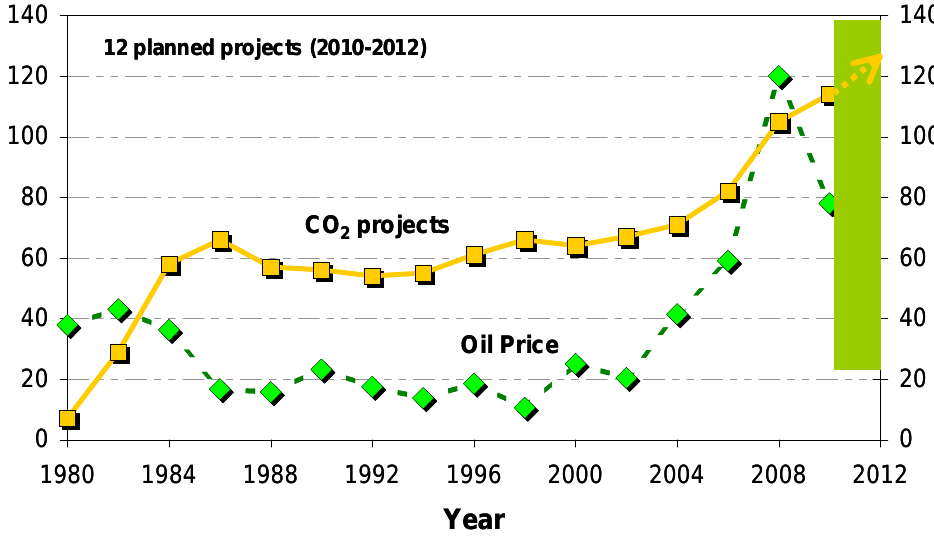
Figure 2. Evolution of CO projects and oil prices in the U.S. (From Oil & Gas 2